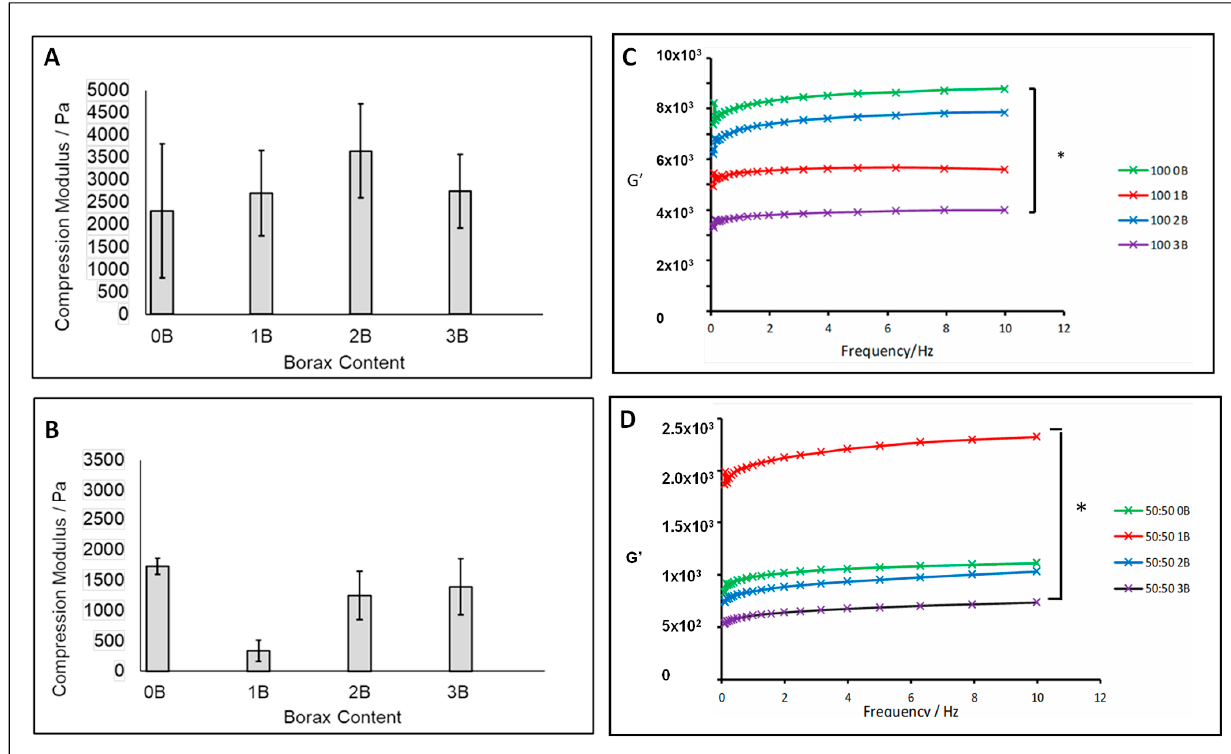
Figure 5. Compression results ( A , B ) and the frequency dependence of storage modulus (G ′ ) ( C , D ) for cryogel sca ff olds. ( A , C ) The cryogels with only high-Mw PVA and variable borax contents; ( B , D ) the cryogels with 50% Mw PVA and variable borax contents (signi fi cance was determined via ANOVA (* p < 0.05)).